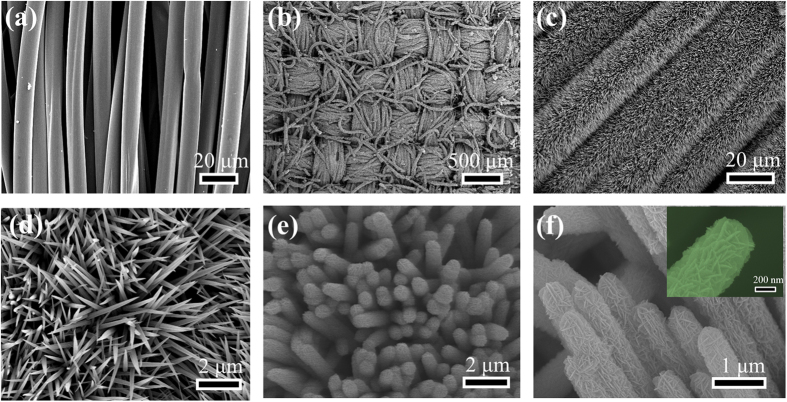
SEM analysis results of as prepared electrode materials.(a) SEM image of bare carbon cloth. (b–d) SEM images of NiCo2O4 nanowires on the carbon cloth. (e,f) SEM images of hierarchical core-shell NiCo2O4@NiMoO4 nanowires on the carbon cloth.